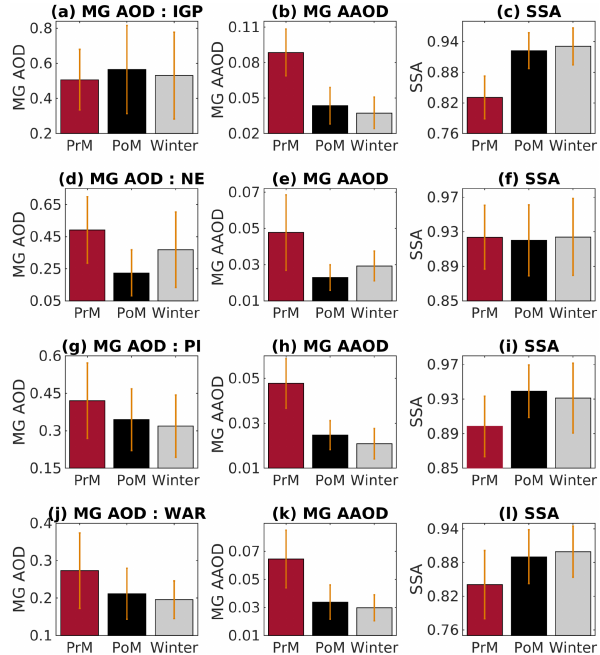
Figure 11. Climatological seasonal cycle of AOD (first column), AAOD (second column) and derived SSA (third column) averaged over IGP (first row), NE (second row), PI (third row) and WAR (fourth row); see Table 1 for acronym